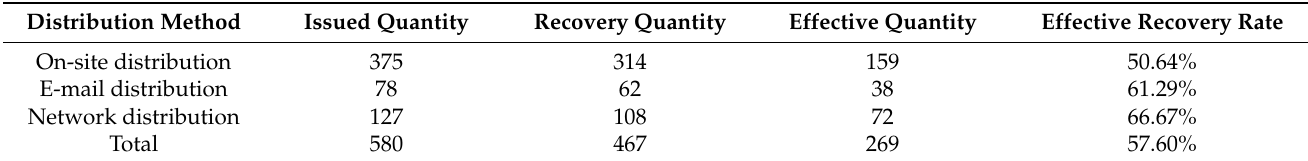
Table 1. Sample distribution and recovery.